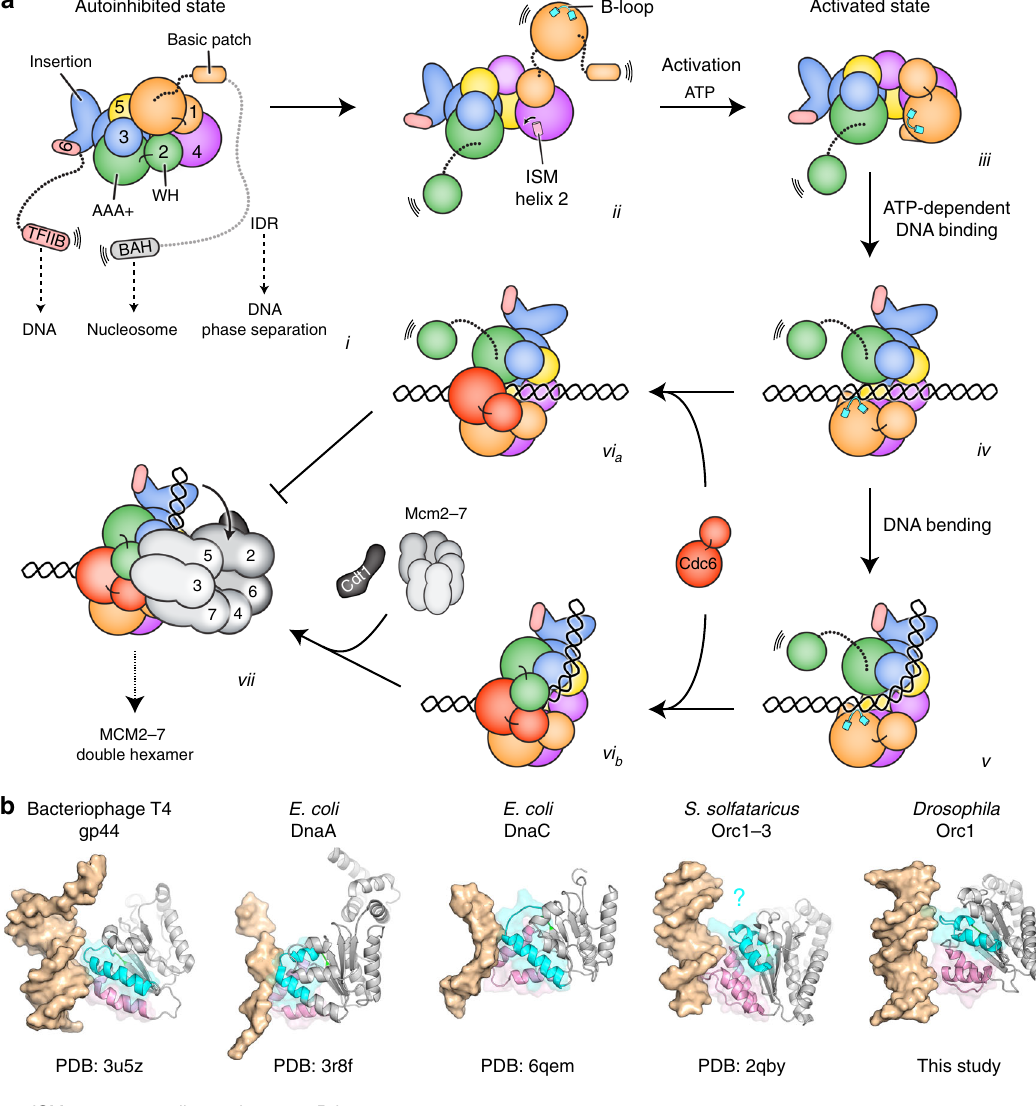
Fig. 7 Metazoan ORC activities during Mcm2 – 7 loading. a Summary of conformational transitions in metazoan ORC and of DNA binding and remodeling mechanisms (panels i-vii , see text for details). ORC regions that have been implicated in recruiting ORC to origins by serving as secondary DNA binding sites (Orc1-IDR, Orc6-TFIIB) or nucleosome-interacting domains (Orc1-BAH) are indicated. The N-terminal region in Orc1 deleted in our construct used for structure determination is shown in gray. TFIIB, transcription factor IIB-like domain in Orc6; BAH, bromo-adjacent homology domain in Orc1; IDR, intrinsically disordered region. b Comparison of DNA contacts in diverse initiator and loader proteins highlights the B-loop element as a common DNA binding region. Archaeal Orc1/Cdc6 constitutes an exception since its B-loop is more distant from DNA compared to the other AAA + ATPase modules. Nucleic-acid bound AAA + domain structures of bacteriophage T4 clamp loader (PDB 3u5z 85 ), E. coli DnaA (PDB 3r8f 12 ) and DnaC (PDB 6qem 59 ), S. solfataricus Orc1-3 (PDB 2qby 6 ), and Drosophila Orc1 (this study) are shown. The initiator-speci fi c motifs (ISM) or corresponding region in the clamp loader, and B-loop regions are depicted as transparent pink and cyan surfaces,